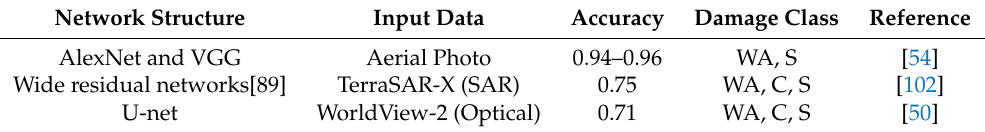
Table 4. Summary of the studies related to the 2011 Tohoku tsunami damage identification using deep learning algorithms. Abbreviations for damage class are as follows: WA = Washed-away, C = Collapsed, S =